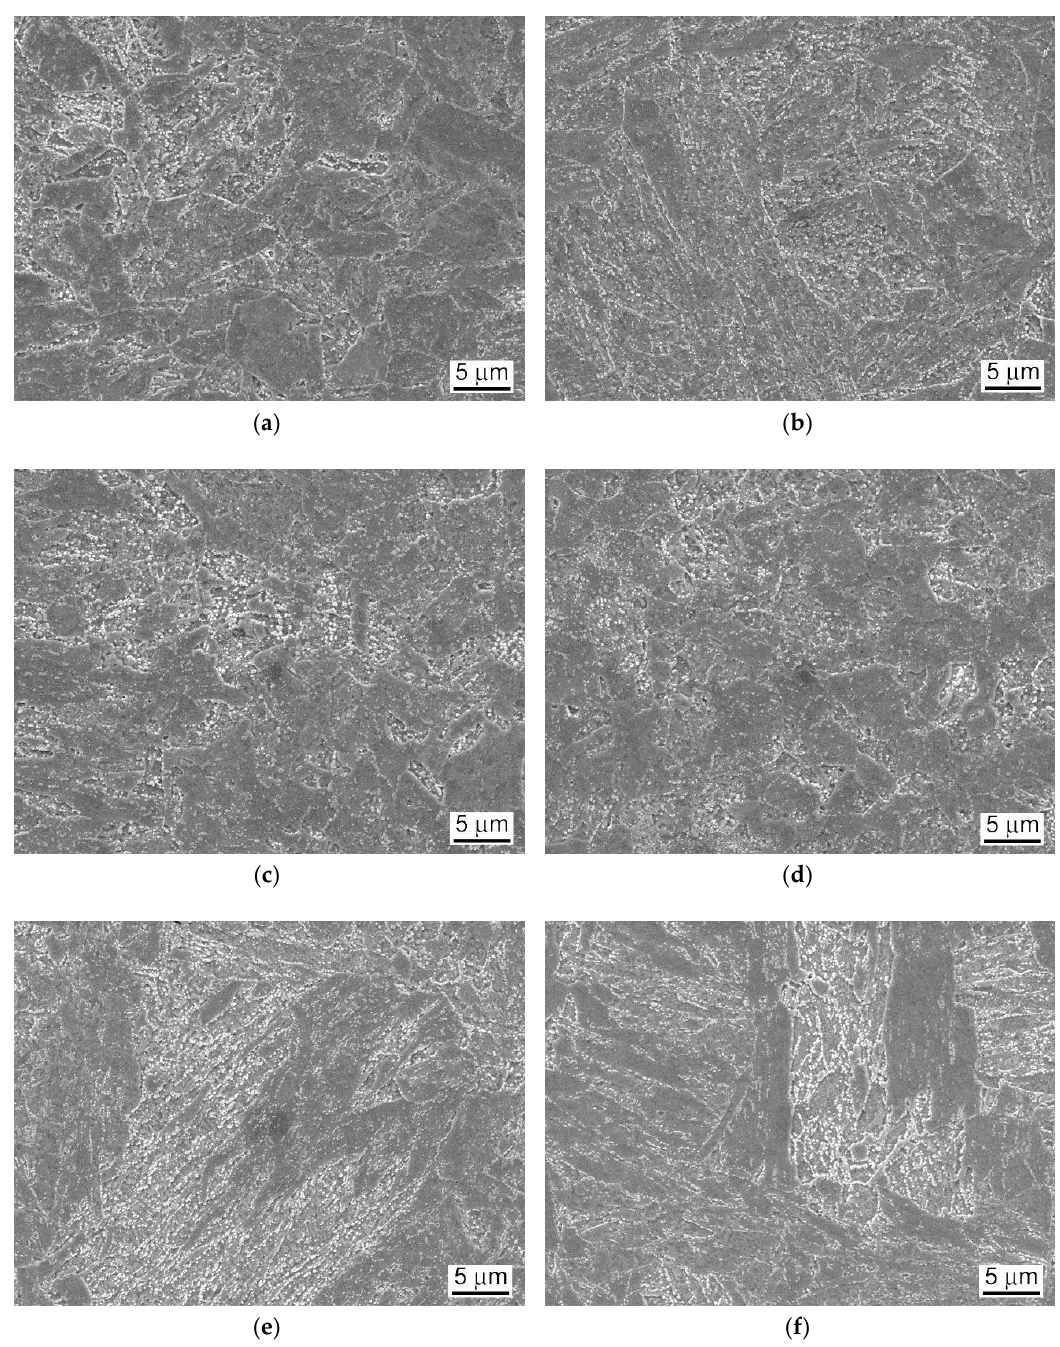
Figure 6. SEM-micrographs of individual microstructural zones of T92/T92 weldment after the tempering PWHT-1: ( a ) BM; ( b ) SC-HAZ; ( c ) IC-HAZ; ( d ) FG-HAZ; ( e ) CG-HAZ; and ( f ) WM.